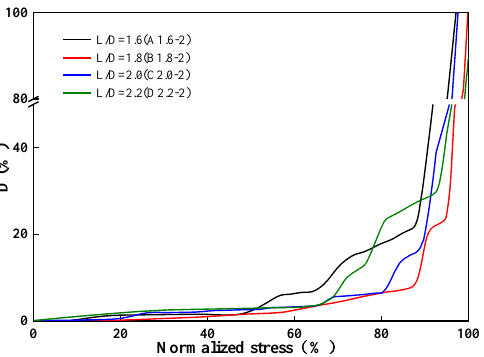
Figure 10. Damage evolution curves of samples with different height to diameter ratios.